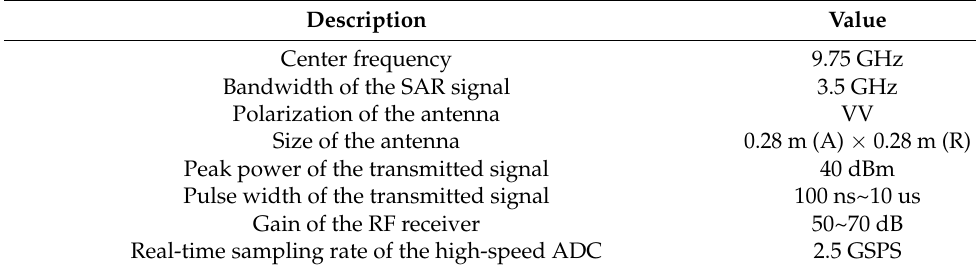
Table 1. The main parameters of the proposed X-band SAR